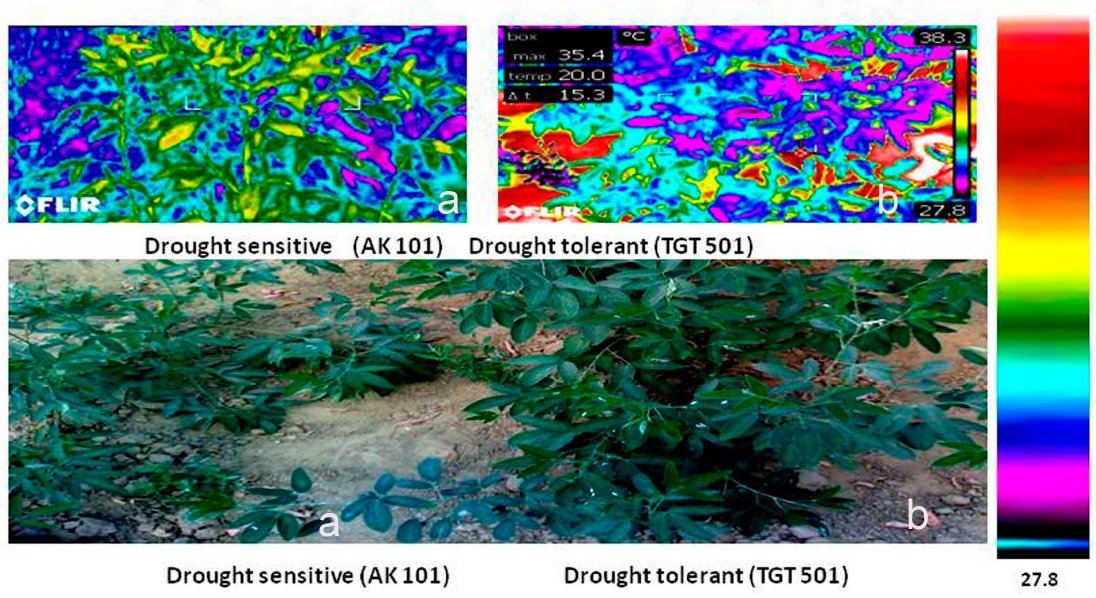
Figure 3. Infra-red thermal imaging describes the canopy temperature. Here two pigeonpea contrasting genotypes ( a ) AK 101 (drought sensitive) and ( b ) TGT 501(drought tolerant) have been used for imaging. Lower canopy temperature is related to a high transpiration rate and could be due to high rooting depth. The genotype ( a ) under drought is showing higher canopy temperature while the genotype ( b ) is showing cooler canopy, hence more drought tolerant under low moisture condition. (Thermal scale is shown with different colors and temperatures ranging between 27.8 to 38.3 °C).